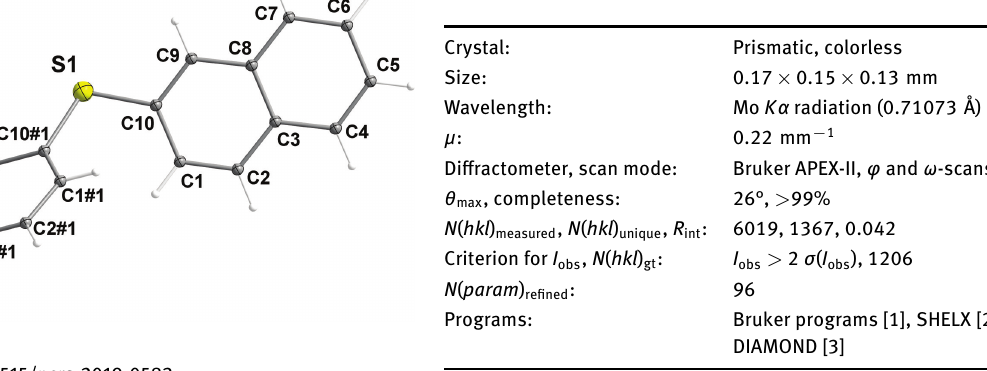
Table 1: Data collection and handling.